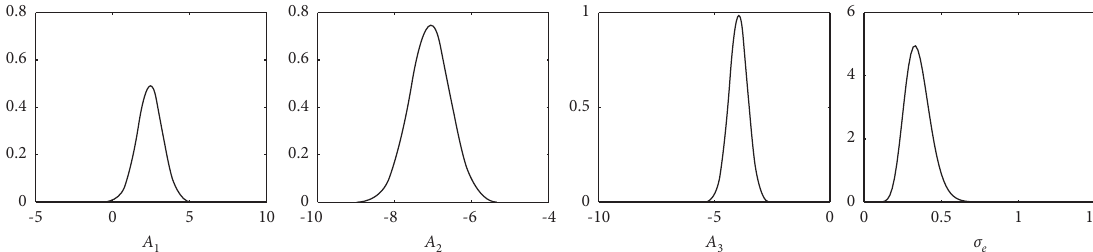
Figure 8: Distributions of A 1 , A 2 , A 3 , and σ e obtained using experimental data of standard specimens.